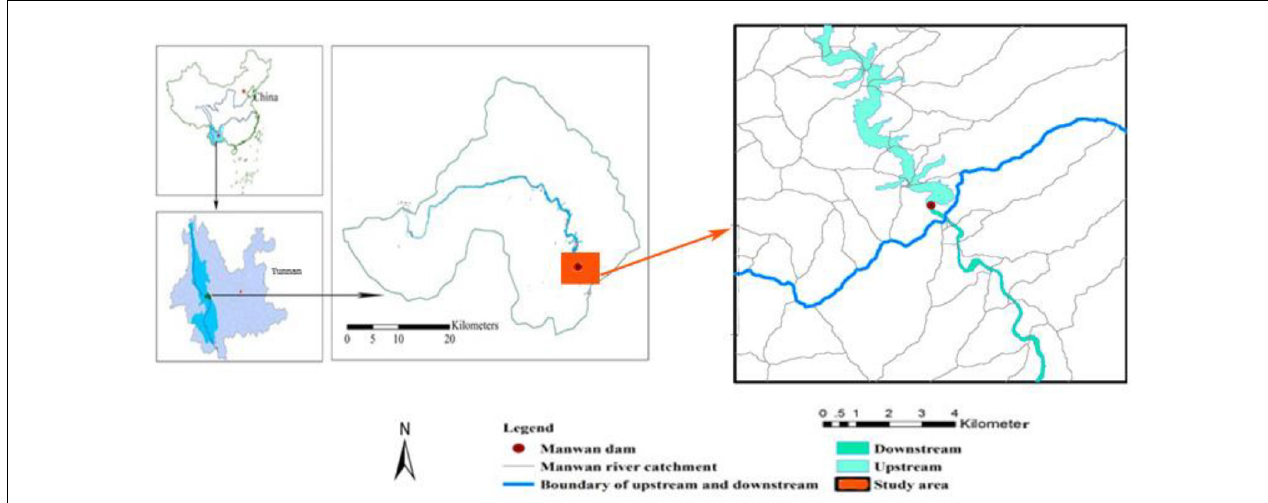
FIGURE 1 | Location of the study